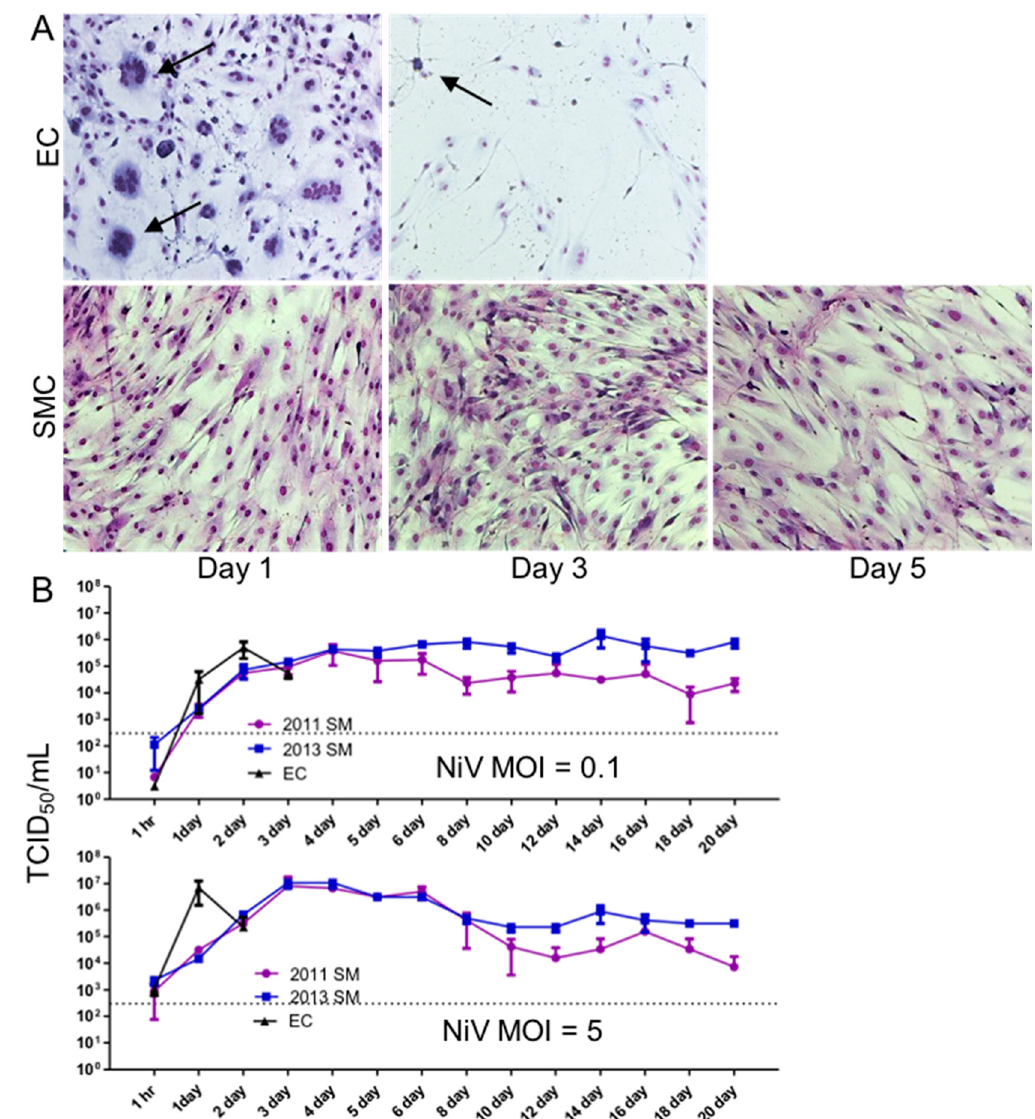
Figure 2. Cytopathic effect and replication of NiV in EC and SMC. ( A ). Monolayers of ECs and SMCs were infected with NiV at a MOI of 0.1 and cells were fixed and stained with Kwik-Diff for visualization. Arrows point to syncytia formation. Images were captured at 10 × magnification. ( B ). ECs and SMCs were infected with NiV at a MOI of 0.1 or 5 and supernatants were collected at the indicated time points, and NiV was quantitated by titration using a TCID 50